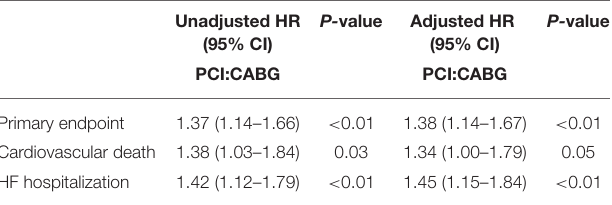
TABLE 2 | Cox proportional hazard models for clinical outcomes after PCI as compared with after CABG in all